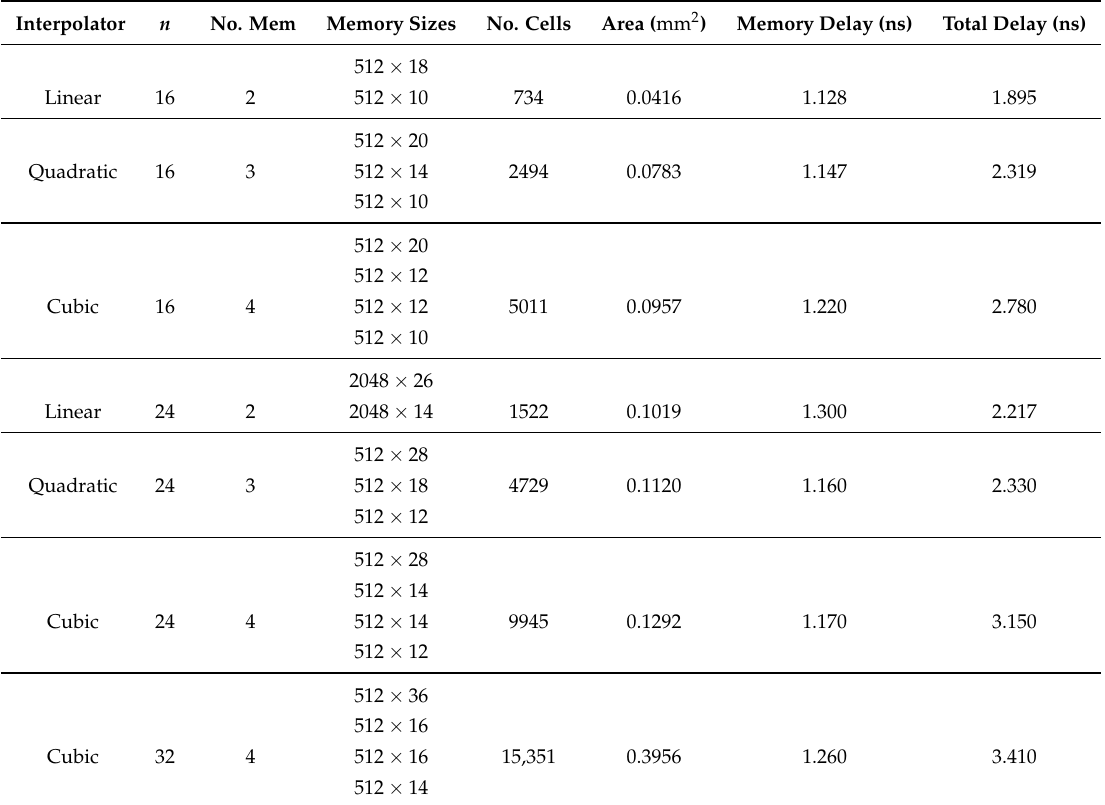
Table 6. Post-layout area and delay results, f ( x ) = 1/ x